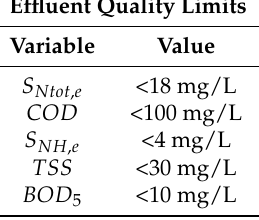
Table 1. BSM2 effluent quality